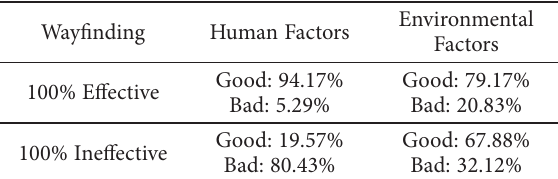
Table 3. The combination of probabilities of ‘Human Factors’ and ‘Airport System’ to achieve completely effective or ineffective wayfinding Wayfinding Human